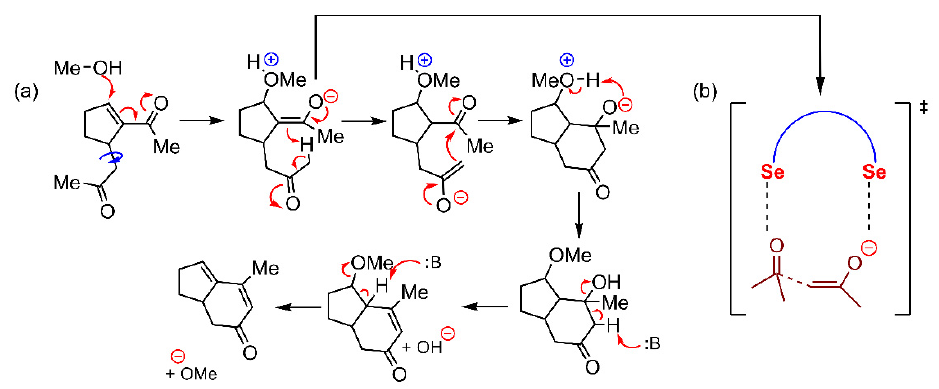
Figure 16. ( a ) Proposed reaction pathway of the Rauhut–Currier reaction and ( b ) Schematic repre- sentation of the plausible stabilized transition state through a dual ChB interaction.